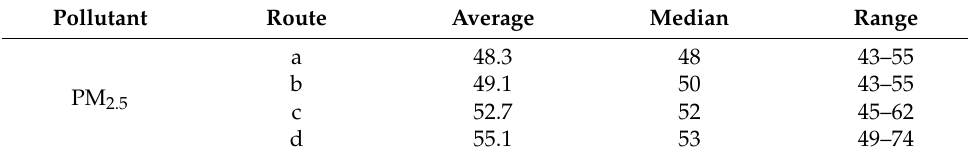
Table A5. PM 2.5 concentrations of four routes in metro carriage on May 19 ( µ g/m 3 ).